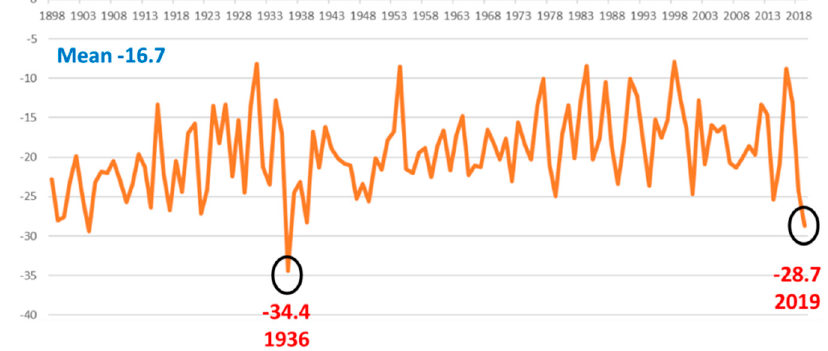
Figure 1. Mean monthly minimum surface air temperature (°C) in Regina, Saskatchewan for February from 1898 to 2019 (Source: Environment and Climate Change Canada).